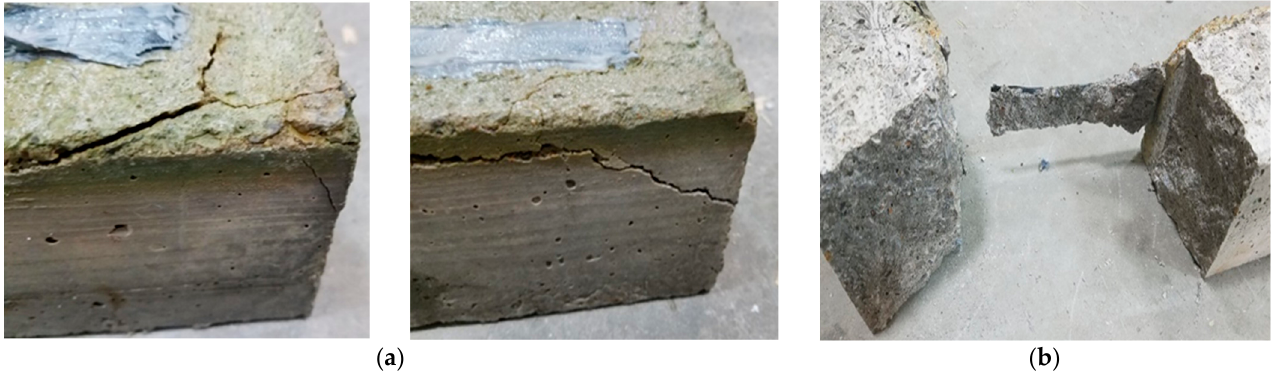
Figure 14. Non-chloride-based deicer concrete deterioration. ( a ) Failure of concrete around the CFRP. ( b ) Mode of failure.